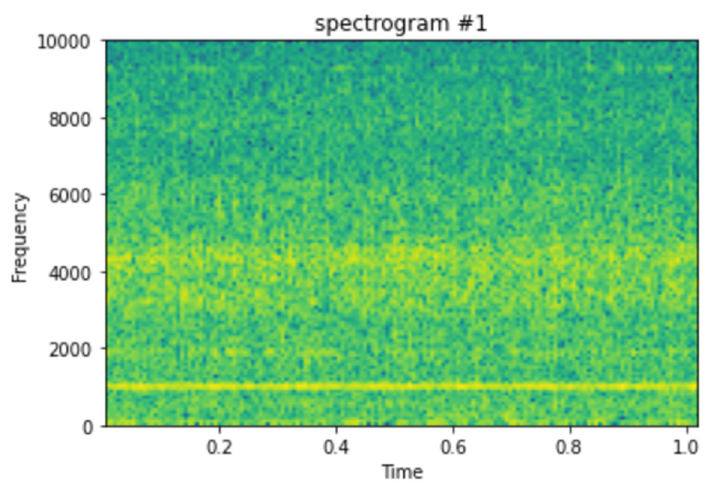
Figure 4. Spectrogram generated for vibrational signal at 10:32:39 on 12 February 2004. Spectrogram Generation